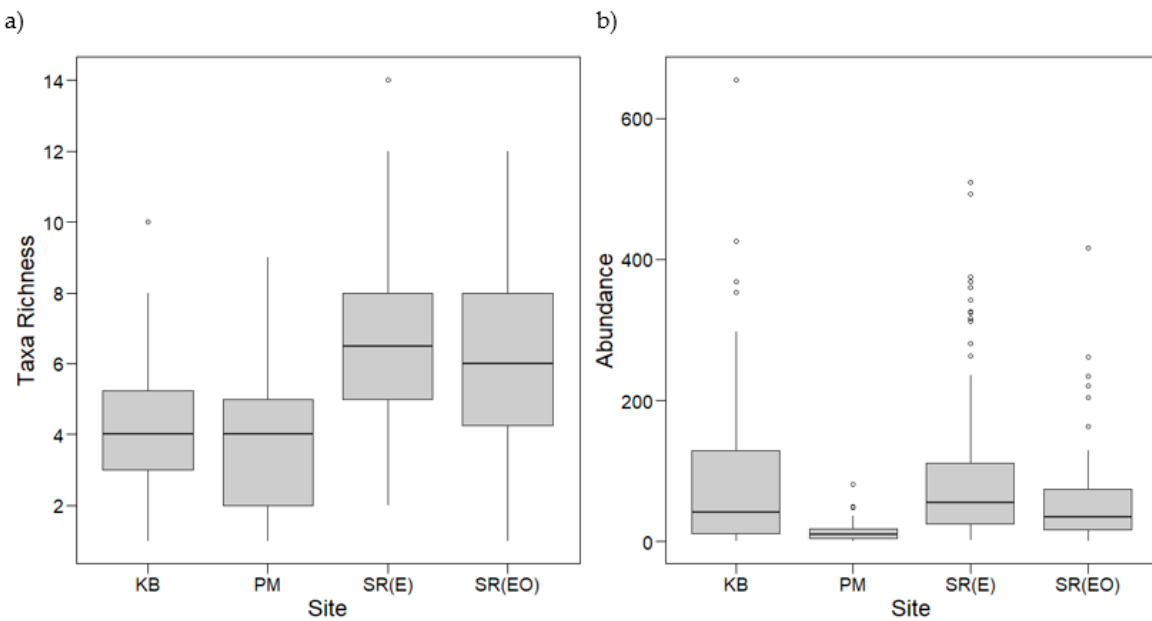
Figure A3. Taxa richness ( a ) and abundance ( b ) of invertebrates from shoot samples collected at natural eelgrass beds Keller Beach (KB, n = 36) and Point Molate (PM, n = 38), and restored populations at the San Rafael project site (SR, n = 102) across three years of post-treatment sampling of eelgrass. Boxplot symbols as in Appendix A Figure A1.